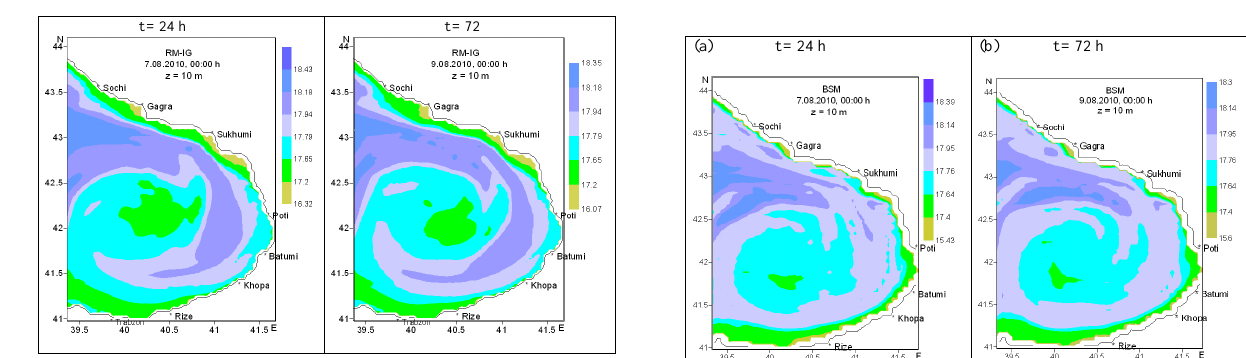
Fig. 9. The temperature fields (deg. C) on depth of 10 m predicted by BSM of MHI at 24 h, (a) and 72 h (b). (the forecasting period is 6.08.2010, 00:00 h –9.08.2010, 00:00 h).